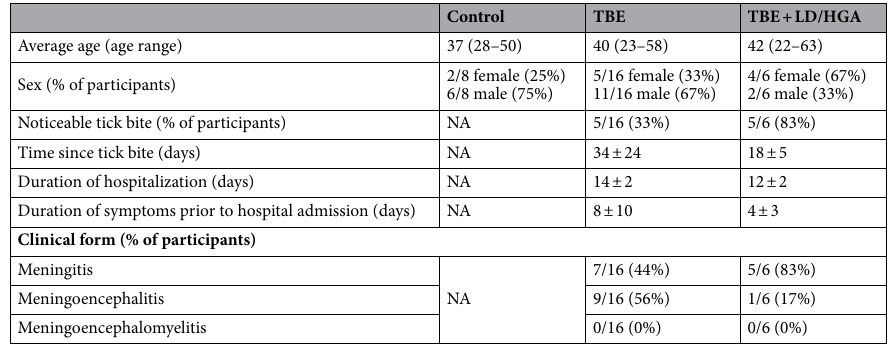
Table 1. Demographic and clinical characteristics of patients with TBE and co-infections (TBE + LD/HGA) compared to healthy subjects. NA not